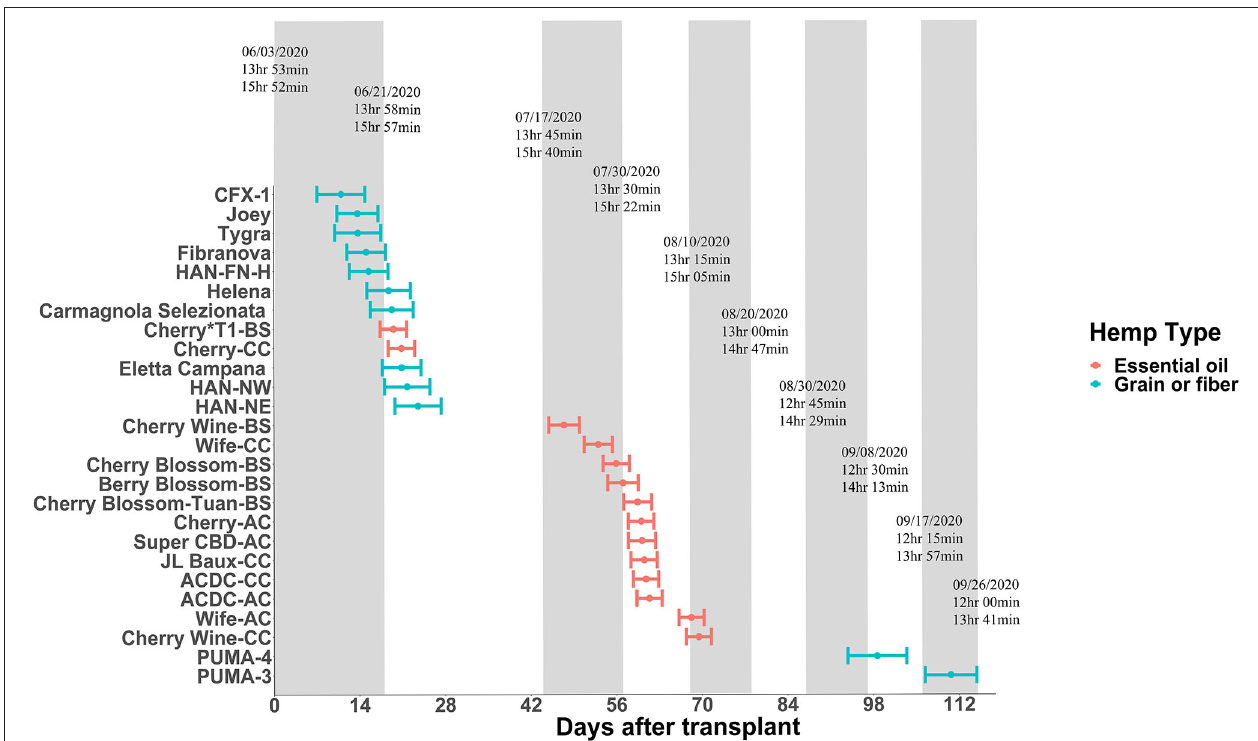
FIGURE 1 | Flowering date of essential oil, grain, and fiber cultivars after transplanting from greenhouse to field conditions on June 3, 2020. Points depict genetic means, and error bars represent 95% confidence intervals. The floating text depicts dates of 15-min daylength intervals (top), sunrise to sunset daylengths (middle), and civil twilight lengths